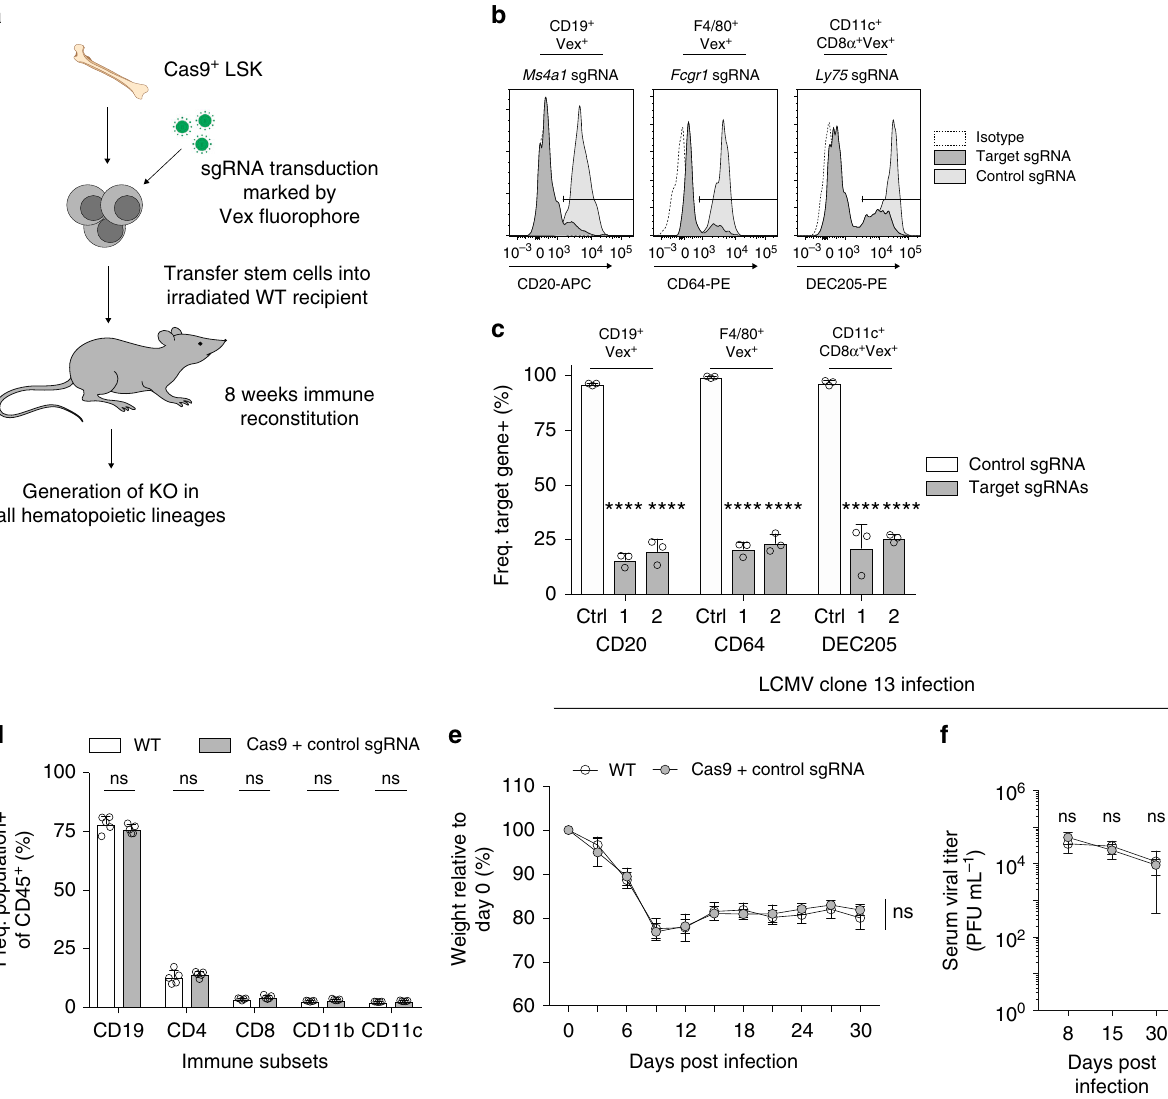
Fig. 1 CHIME enables deletion of genes without impairing immune homeostasis. a Schematic of chimeric CRISPR-Cas9 system. b CD20 (left), CD64 (middle), or DEC205 (right) expression on B cells, macrophages, or dendritic cells, respectively from chimeric animals following transduction with a non- targeting control sgRNA or targeting sgRNAs to Ms4a1 , Fcgr1 , or Ly75 . c Quanti fi cation of CD20, CD64, and DEC205 expression on relevant lineages from ( b ). d Comparison of frequencies of major immune lineages (of CD45 + ) in chimera mice (WT: WT stem cells mock transduced, Cas9 + sgRNA: Cas9 stem cells transduced with the Vex sgRNA expression vector) at homeostasis. e , f Chimeric mice were infected with 4 × 10 6 plaque-forming units (PFU) LCMV Clone 13 and their weight loss (e) and serum viral titer (f) were determined. All experiments had at least three biological replicate animals per group and are representative of two independent experiments. Bar graphs represent mean and error bars represent standard deviation. Statistical signi fi cance was assessed among the replicate bone marrow chimeras by one-way ANOVA ( c , d ), or two-way ANOVA ( e , f ) (* p < .05, ** p < .01, *** p < .001, **** p < .0001). See also Supplementary Fig. 1 and 2. Source data are provided as a source data fi